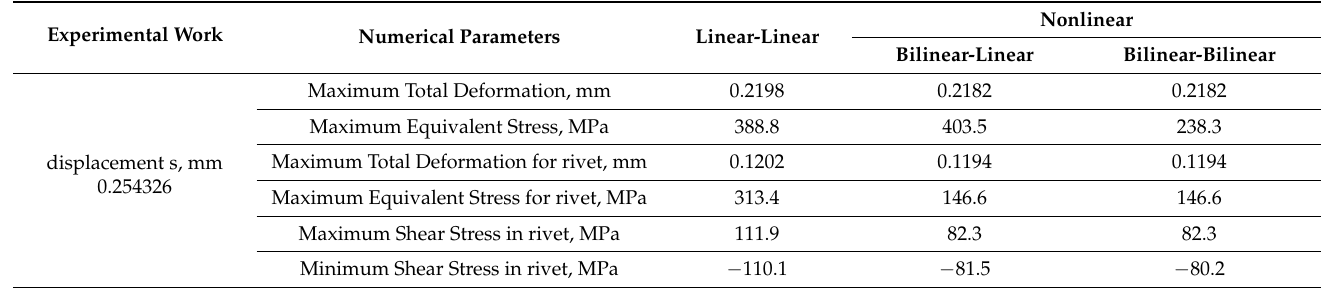
Table A3. Experimental and numerical results for the load force F = 600